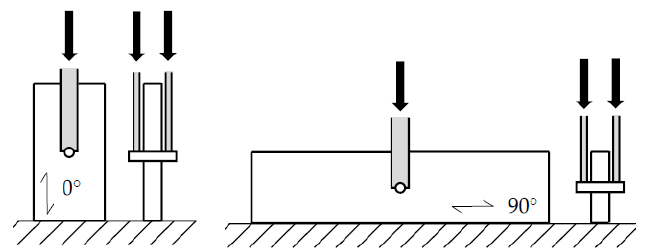
Figure 10. Test setup for the embedment tests at a load-to-grain angle 0° and 90° [34].